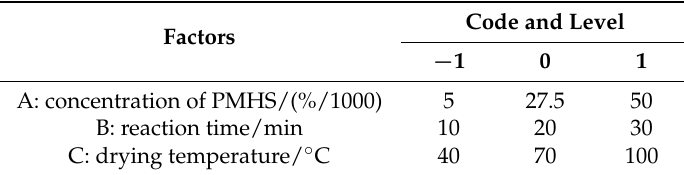
Table 1. Experimental factors and coding level.